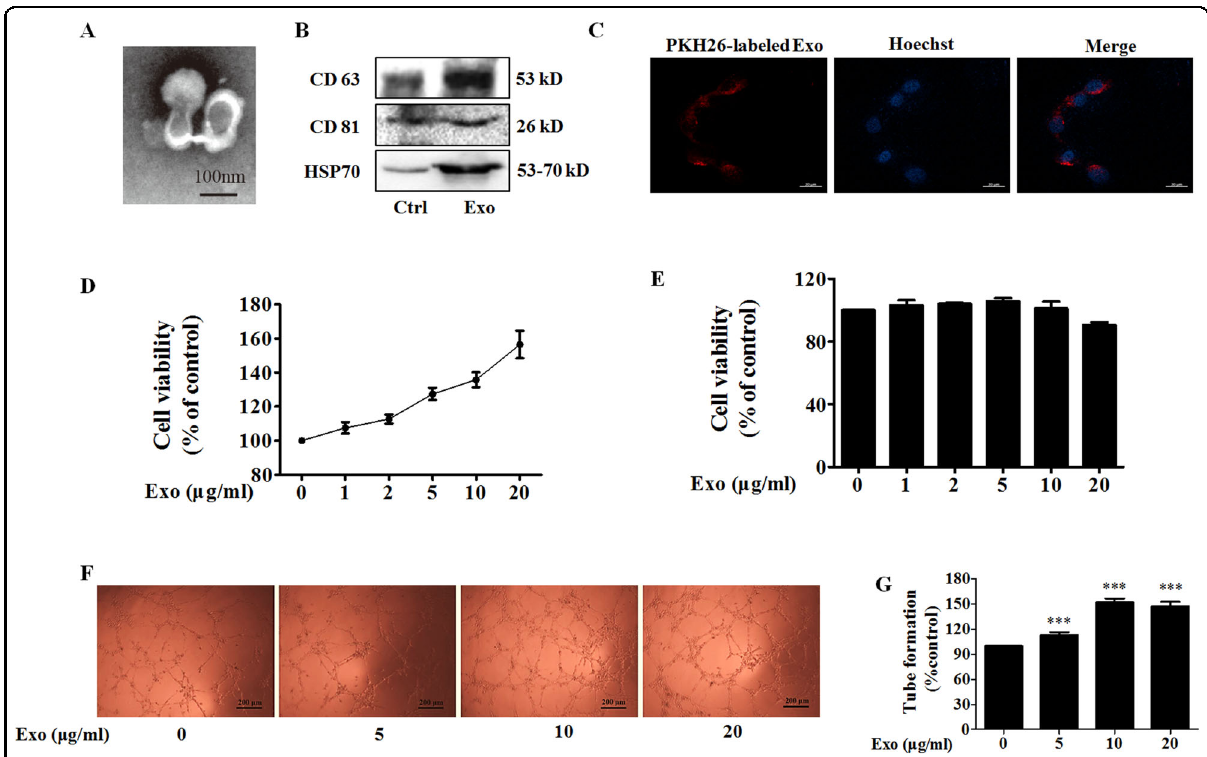
Fig. 1 Exo promotes human umbilical vein endothelial cells (HUVEC) tube formation. A A representative transmission electron microscopic image of exosomes derived from MDA-MB-231 cells. B The protein markers of exosomes in Exo as determined by western blot. C The uptake of Exo labeled with PKH26 in HUVECs. D Effect of Exo on HUVEC viability. E Effect of Exo on MDA-MB-231 cell viability. F Exo promotes HUVEC tube formation. G Quanti fi cation of the results in ( F ), Data represent mean ± SEM from three independent experiments ( n = 3). *** P < 0.001, compared with control (0 μ